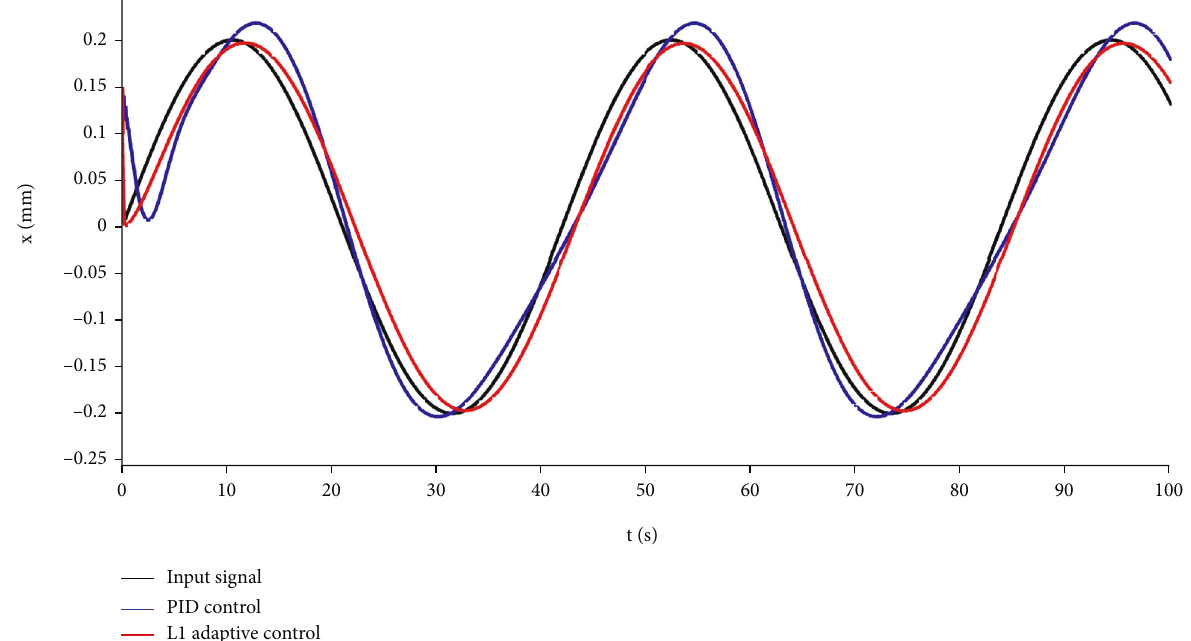
Figure 11: Input sinusoidal signal without interference in tracking signal